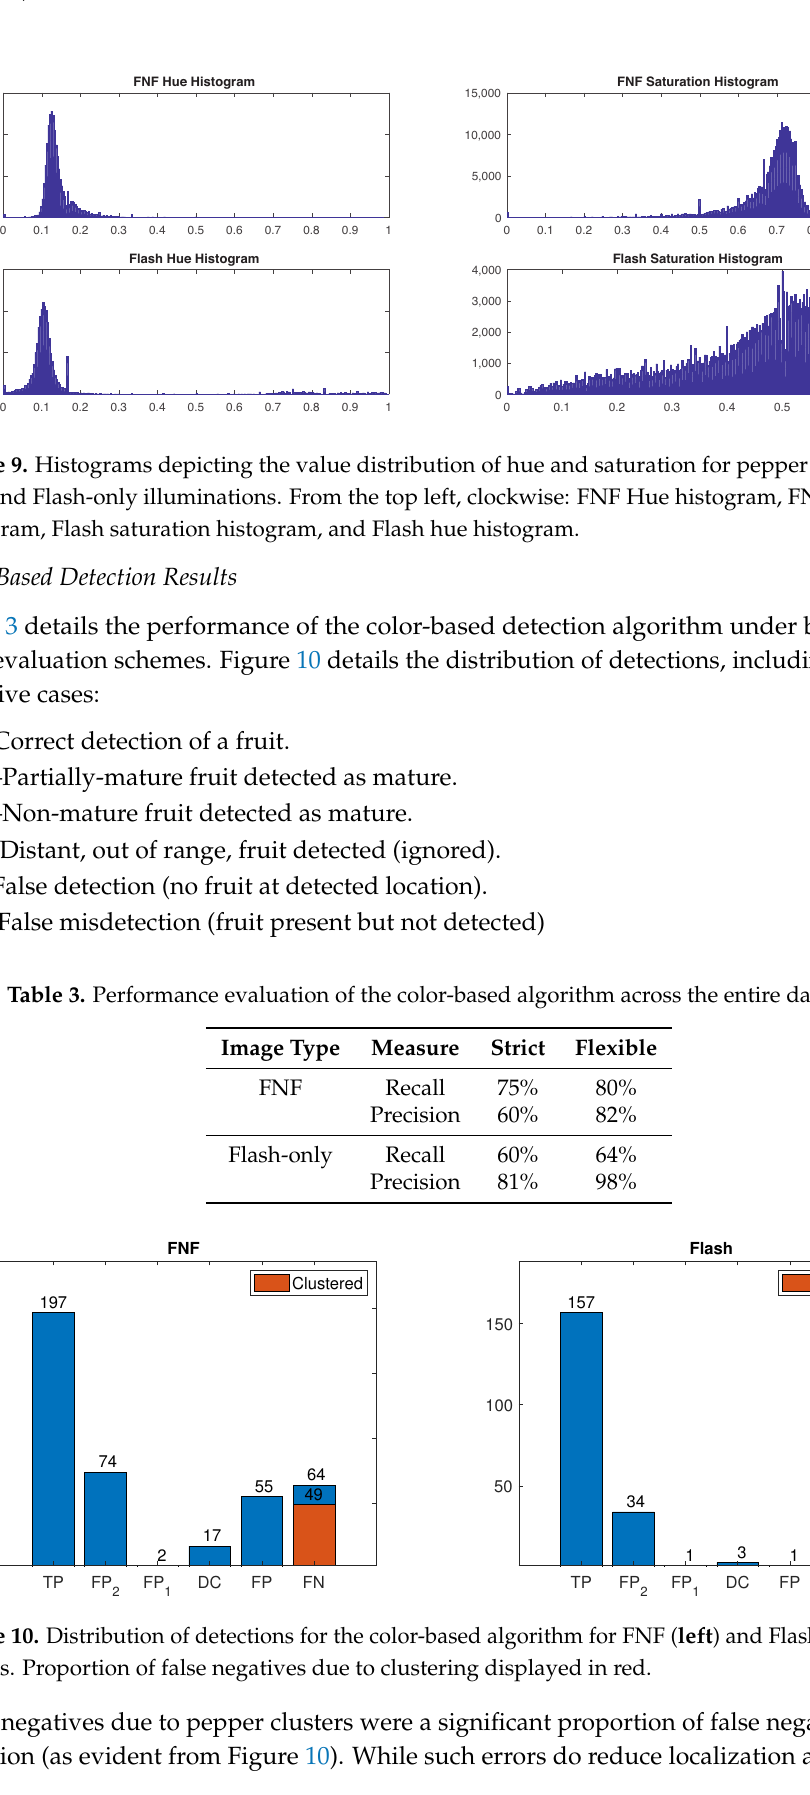
Figure 10. Distribution of detections for the color-based algorithm for FNF ( left ) and Flash-only ( right ) images. Proportion of false negatives due to clustering displayed in